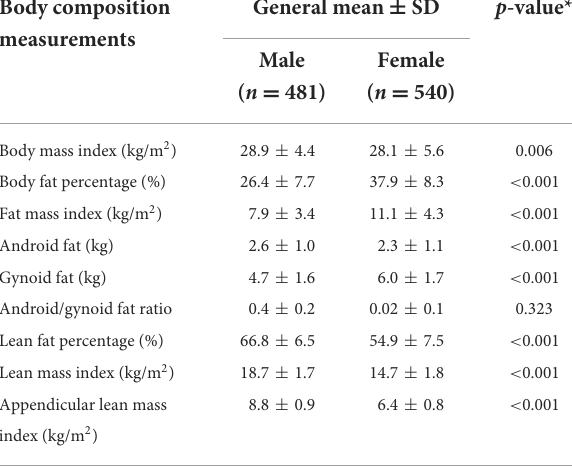
TABLE 3 Mean of body composition measurements at 37–39 years (2016/2017) according to sex of participants of the 1978/1979 Ribeirão Preto birth cohort study (São Paulo,